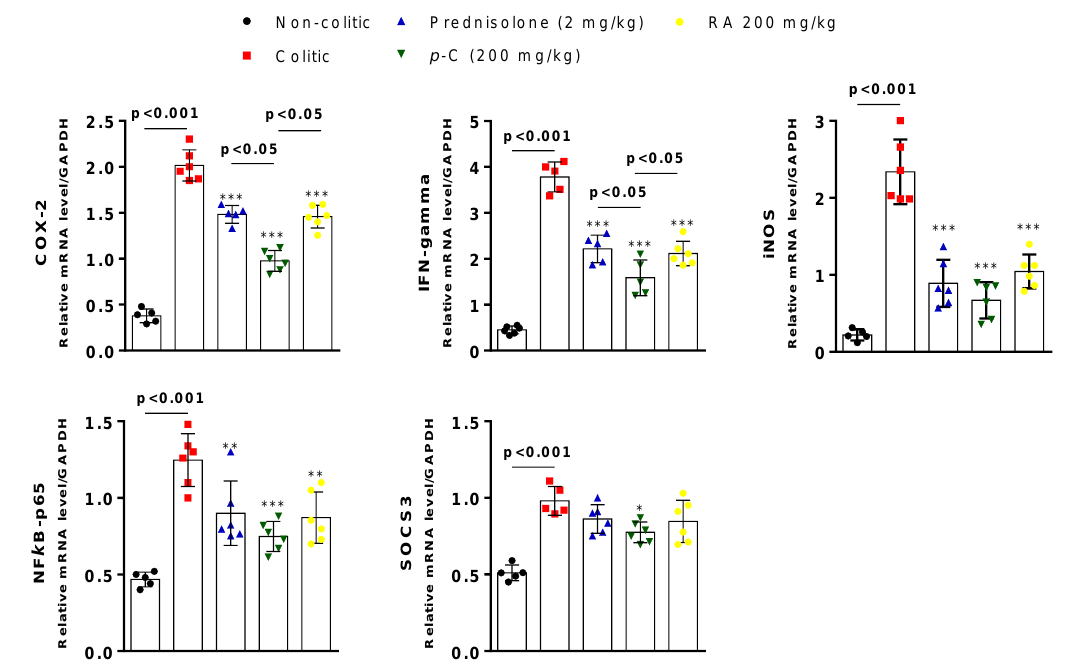
Figure 8. E ff ect of oral administration of p -C and RA in cyclooxigenase 2 (COX-2), interferon (IFN)- γ , inducible nitric oxide synthase (iNOS), suppressor of cytokine signaling 3 (SOCS3), and nuclear transcription factor kappa B subunit p65 (NF κ B-p65) expression on TNBS-induced ulcerative colitis rat model. Data are expressed as mean of cell percentages ± standard error, having been analyzed by one-way ANOVA followed by Dunnett’s or Tukey’s test. *** p < 0.001, ** p < 0.01, * p < 0.05 compared to colitic control groups ( n = 5–6).